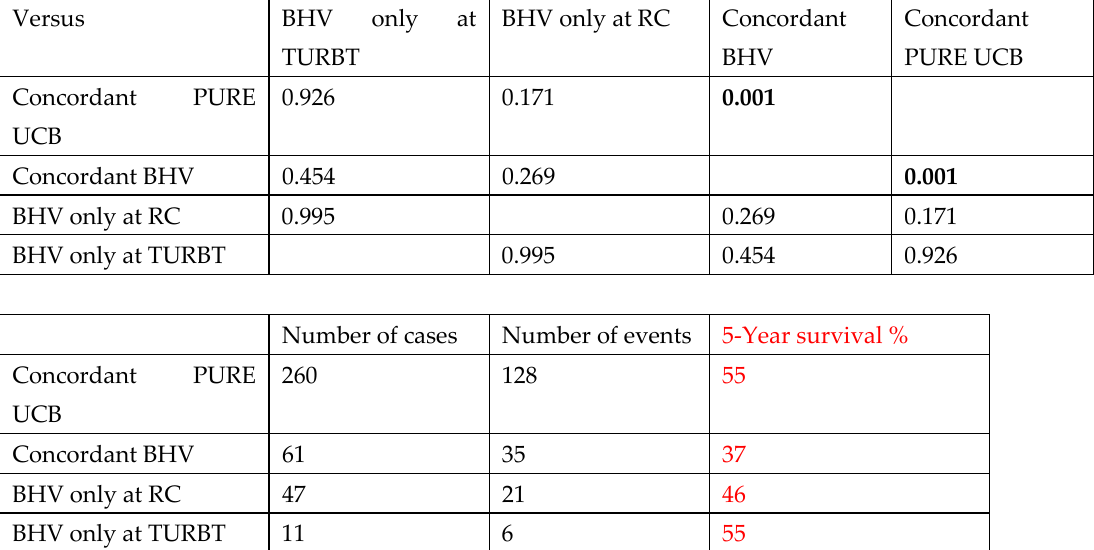
Figure 2. The Kaplan–Meier curve assessing recurrence-free survival rates, ( A ) CSM-free survival ( B ) and OM-free rates ( C ) stratified for histology between TURBT and